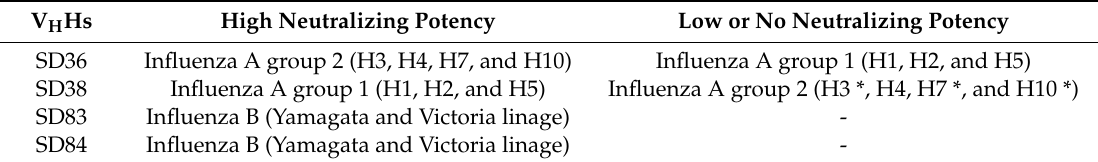
Table 1. Neutralizing potency of isolated V H Hs against the influenza A or B viruses [8]. Neutralizing titer was determined by in vitro microtiter